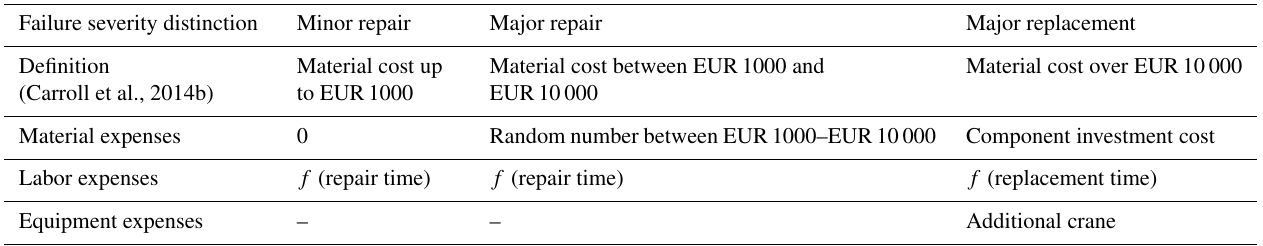
Table 1. Failure severity distinction based on Carroll et al. (2014b) and model